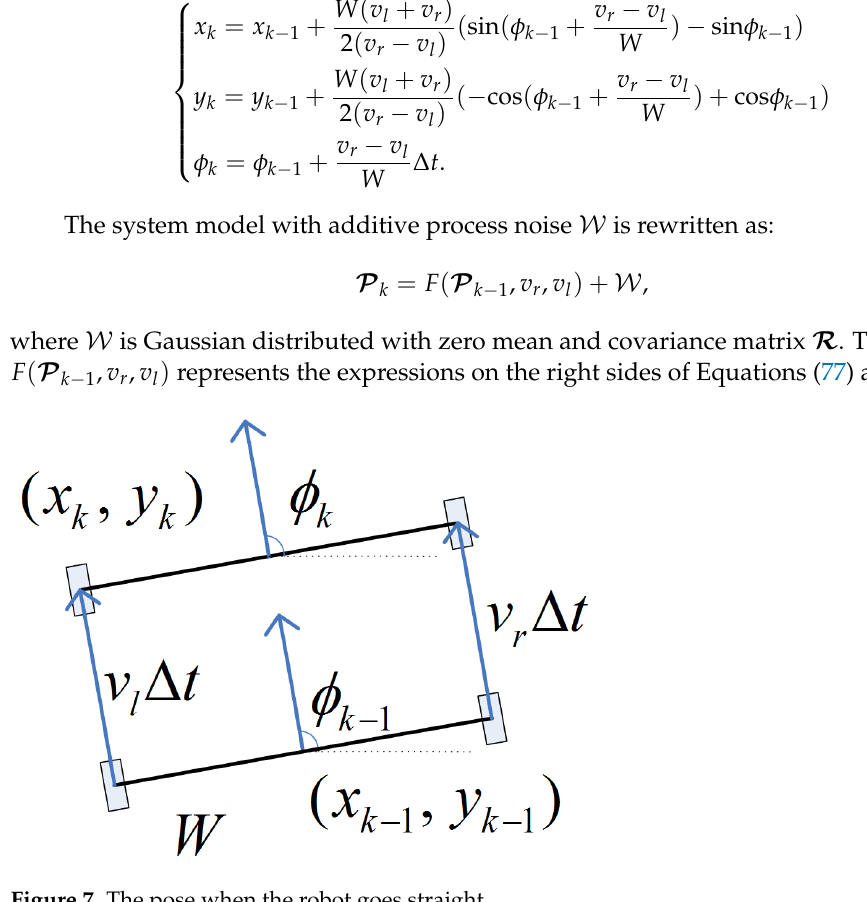
Figure 7. The pose when the robot goes